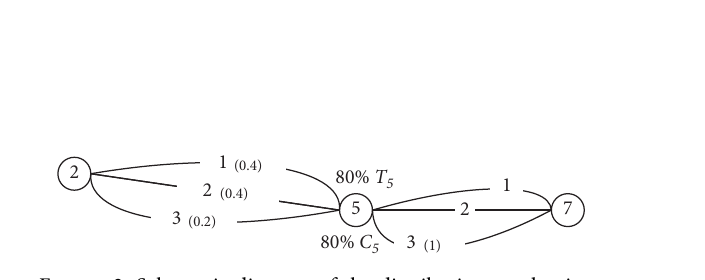
Figure 2: Schematic diagram of the distribution